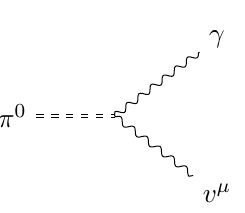
Figure 12. Feynman diagram for the π 0 → γv µ